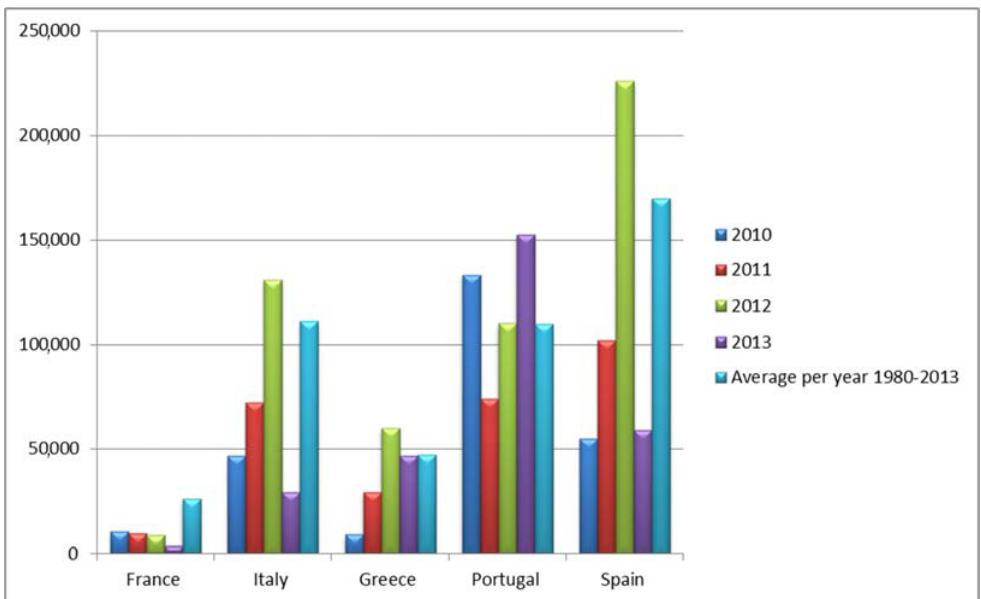
Figure 1. Averaged annual burned area in the European countries most affected by fires between 1980 and 2013, compared with more recent years [2].